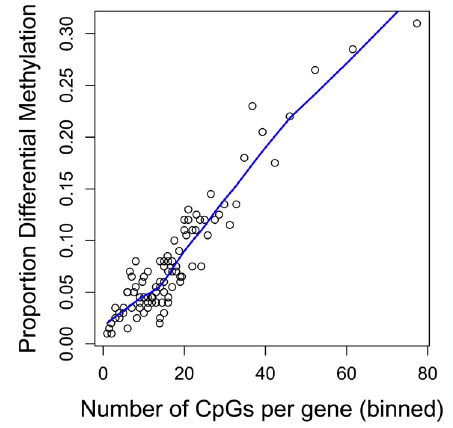
Figure 12. Bias resulting from different numbers of CpG probes in different